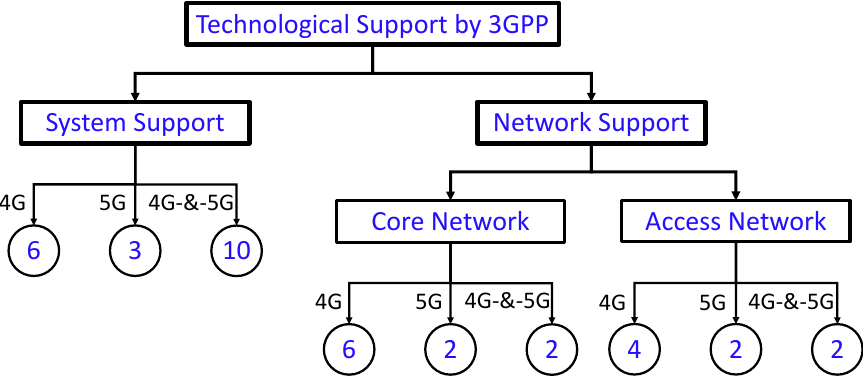
Figure 9. Frequency of system and network support for AD usecase groups through cellular